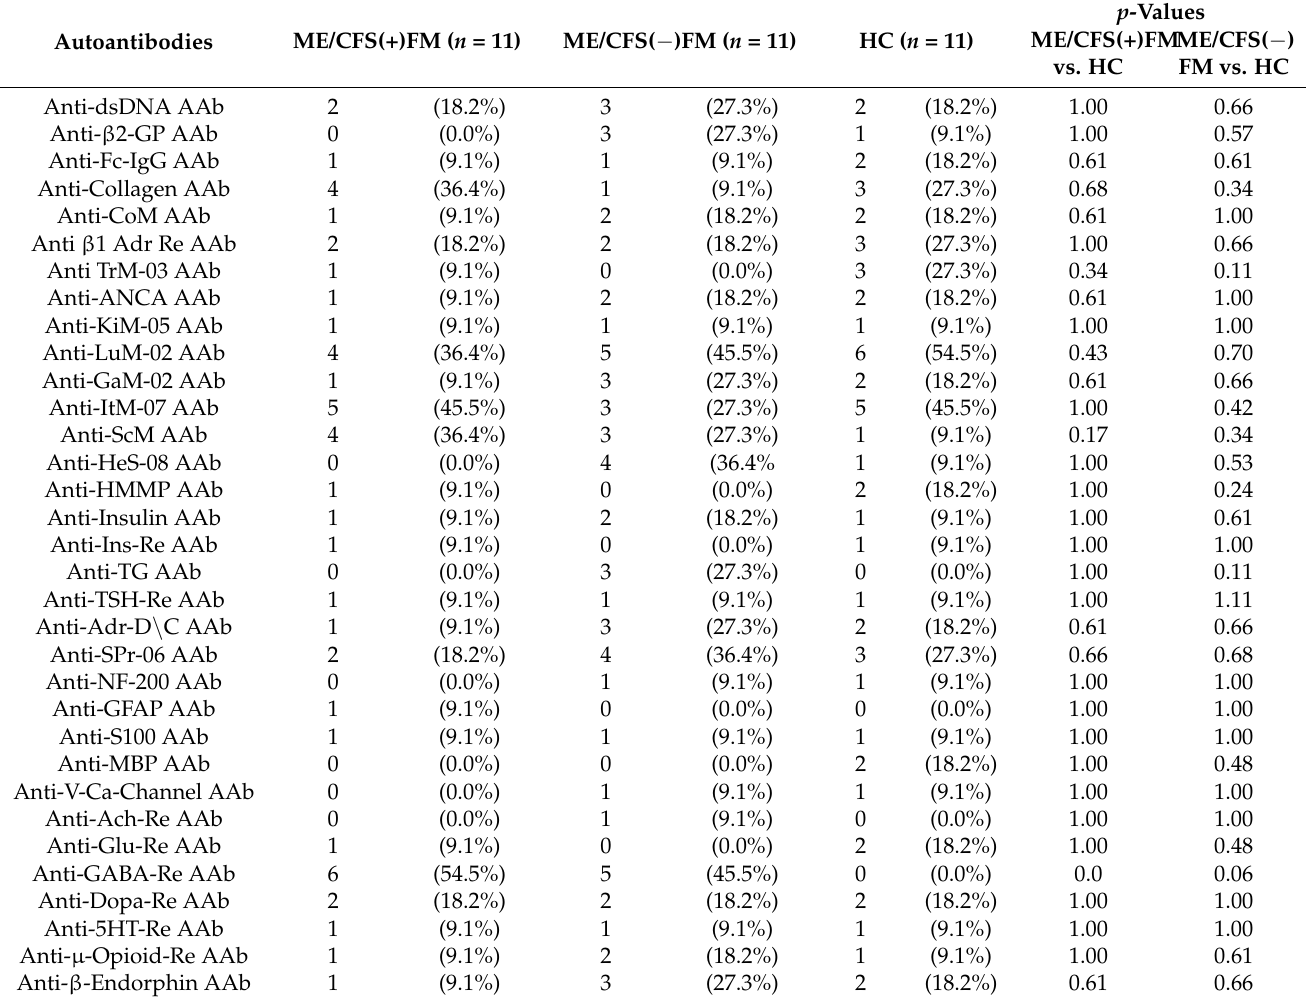
Table 4. Number of patients and HC with abnormal deviation (as a percentage of the AIR) of the patient’s serum reactivity towards the studied antigens. FM—fibromyalgia, HC—heathy controls, ME/CFS—myalgic encephalomyelitis/chronic fatigue